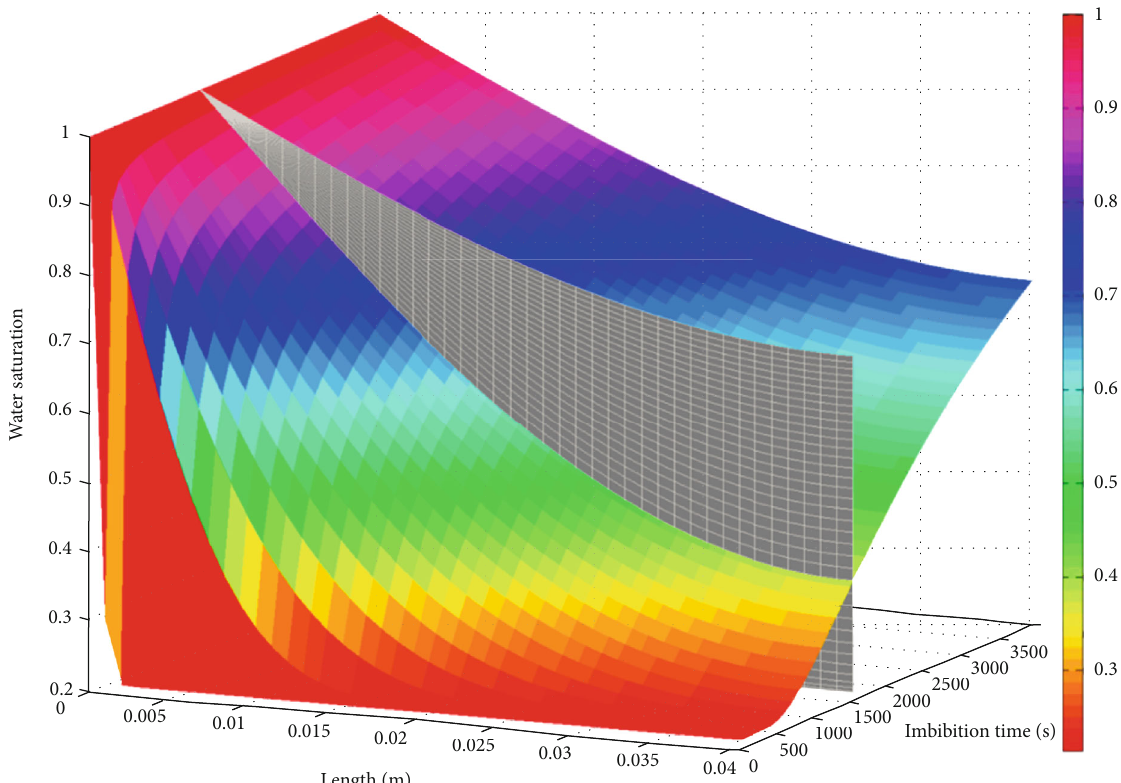
Figure 6: Water saturation distribution in respect to position and time from the results of the numerical method.